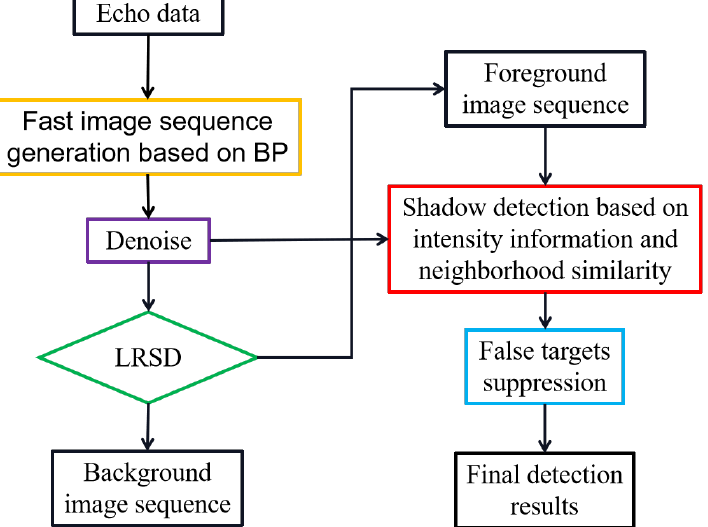
Figure 1. Flow chart of the proposed moving target shadow detection method. Here, the LRSD and BP represent the low-rank and sparse decomposition and back-projection, respectively.